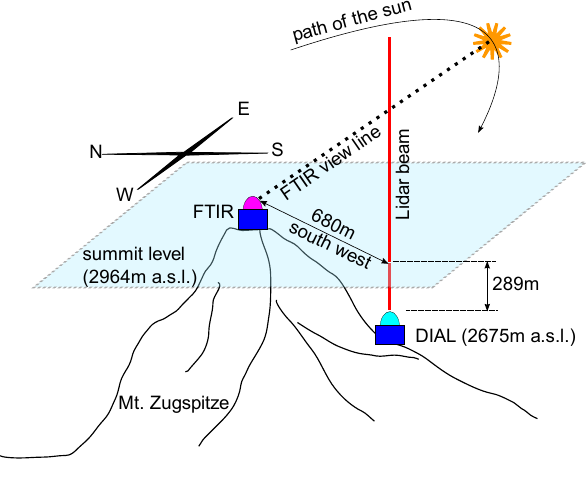
Fig. 1. Collocation of the FTIR and the DIAL on Mt. Zugspitze. The volume matching of the FTIR instrument and the DIAL peaks in the early afternoon at an azimuth of about 210 ◦